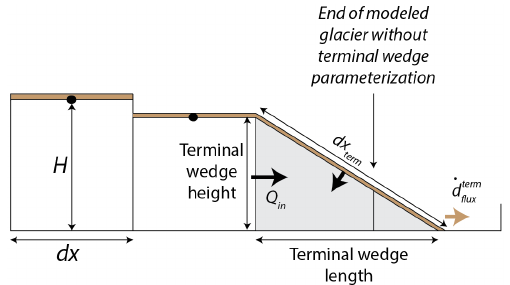
Figure A1. The terminal wedge parameterization and debris re- moval from the model. Q in is the ice discharge into the terminal wedge. ˙ d term is removed from the total volume of surface debris on flux the terminal